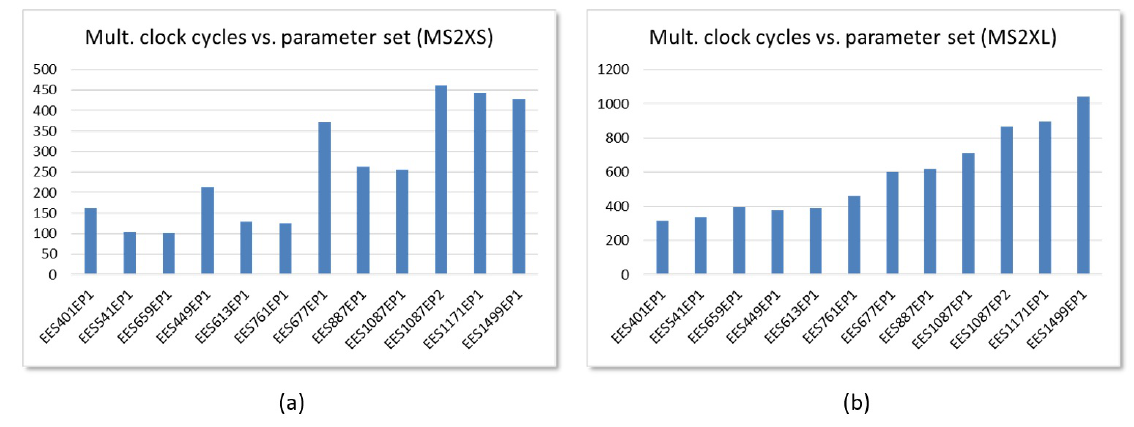
Figure 18. Clock cycles required to complete polynomial multiplication using the different IEEE Std 1363.1 parameter sets for embedded systems that incorporate: ( a ) MS2XS IPs with M = 6 implemented in a Zynq UltraScale+; ( b ) MS2XL IPs with M = 8 implemented in a Zynq-7000